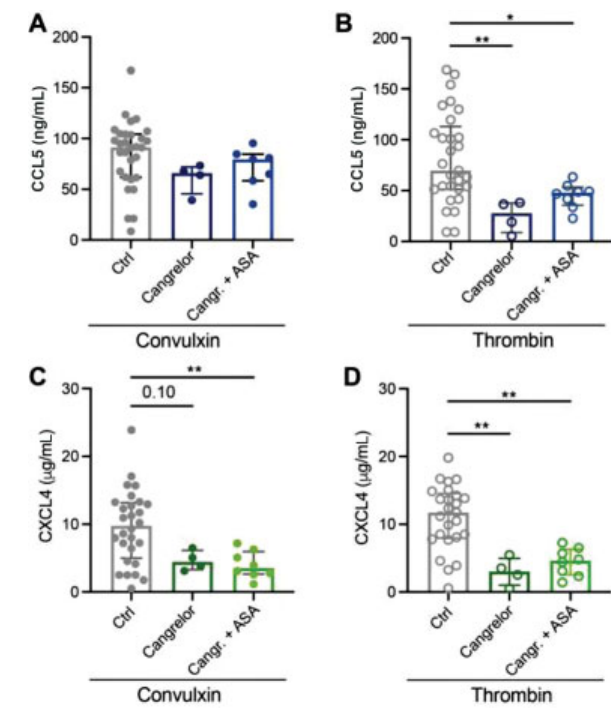
Fig. 4 Effects of P2Y 12 inhibition on chemokine release. Washed platelets (2 (cid:1) 10 8 /mL) from healthy volunteers exposed to acetylsalicylic acid (ASA: 100mg p.o.) were activated and CCL5 ( A, B ) and CXCL4 ( C, D ) release was determined as described. Prior to activation, platelets were incubated with P2Y 12 inhibitor cangrelor for 5minutes. Closed circles represent convulxin activation and open circles represent thrombin activation. CTRL: n ¼ 25 – 30; Cangrelor: n ¼ 4; Cangr. þ ASA: n ¼ 8. Median with interquartile range. (cid:4) p < 0.05; (cid:4)(cid:4) p < 0.01; Kruskal – Wallis with Dunn ’ s